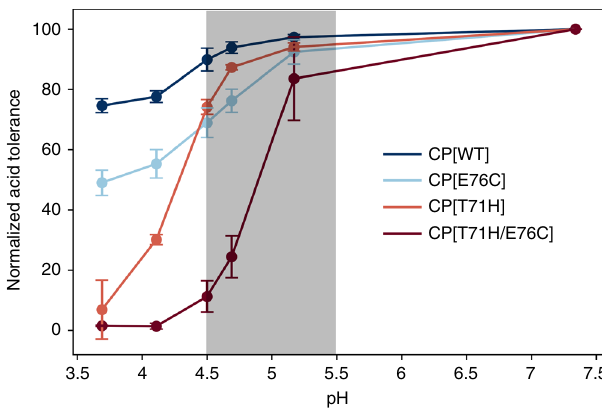
Fig. 6 Reduced acid tolerance of MS2 CP[T71H] and CP[T71H/E76C]. Both CP[T71H] and CP[T71/E76C] are less acid tolerant than CP[WT] and CP [E76C]. Normalized acid tolerance ( n = 3) indicates HPLC SEC peak height relative to pH 7.3. The highlighted region is ideal for